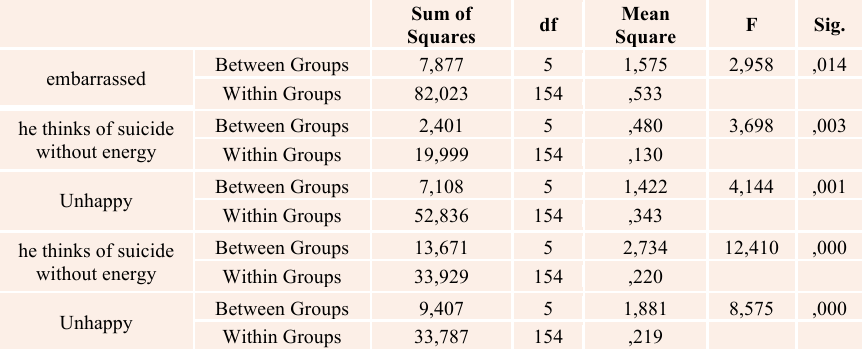
Table 2. Analysis of variance of Self-report questionnaire for children and adolescents on the occurrence of a traumatic